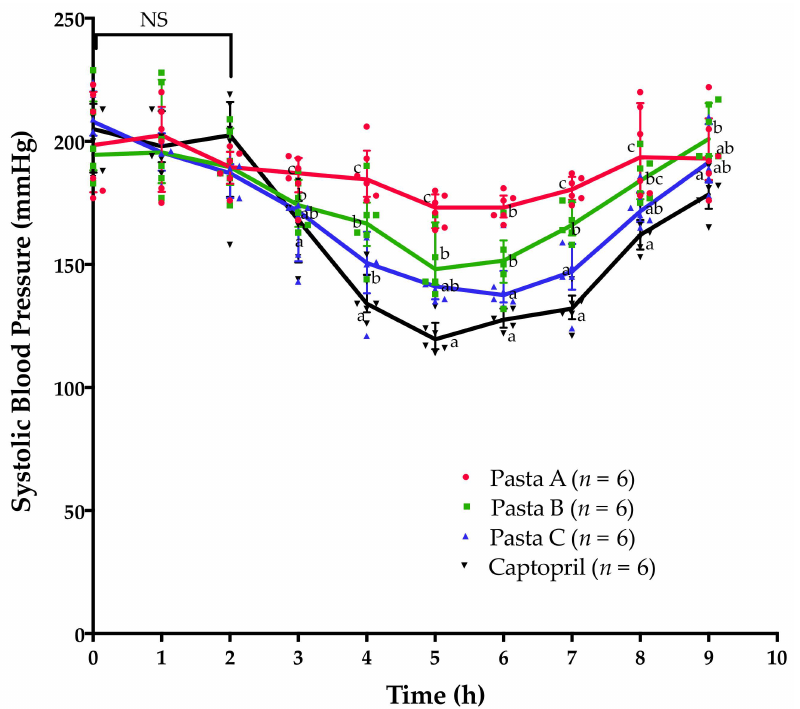
Figure 4. Systolic blood pressure in spontaneously hypertensive rats after supplementation with three types of pasta and captopril. Comparisons at each time point were carried out using nonparametric ANOVA and Kruskal–Wallis test. Di ff erent letters at specific time points mean significant di ff erence ( p < 0.05). NS: nonsignificant di ff